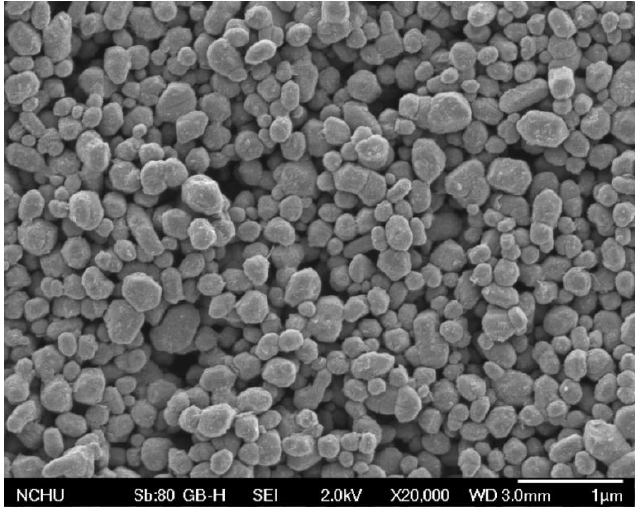
Figure 4. SEM image of the titanium dioxide film.